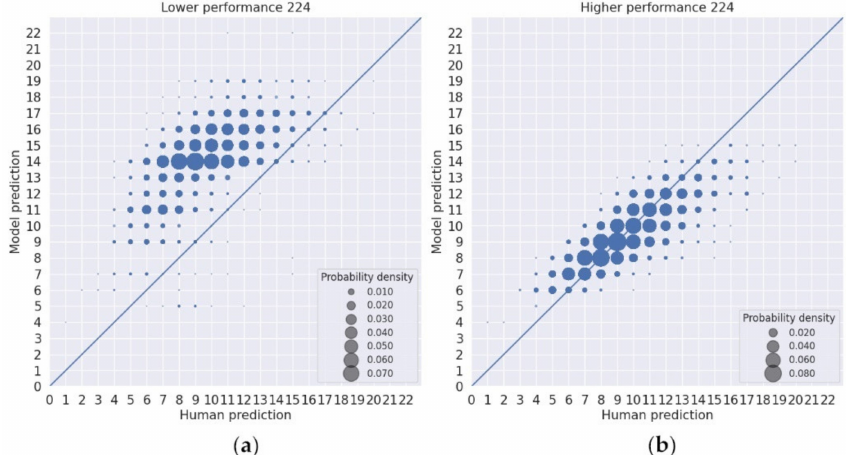
Figure 5. Model age predictions vs. human annotated age obtained on the Icelandic data for the lower and higher performance experiments (using images of size 224 × 224). For each model, the age predictions correspond to the calculated median from the predicted ages obtained over the 5 different trials. The scatters have an area proportional to the probability density of data. ( a ) Age predictions for the lower performance bound; ( b ) age predictions for the higher performance bound.